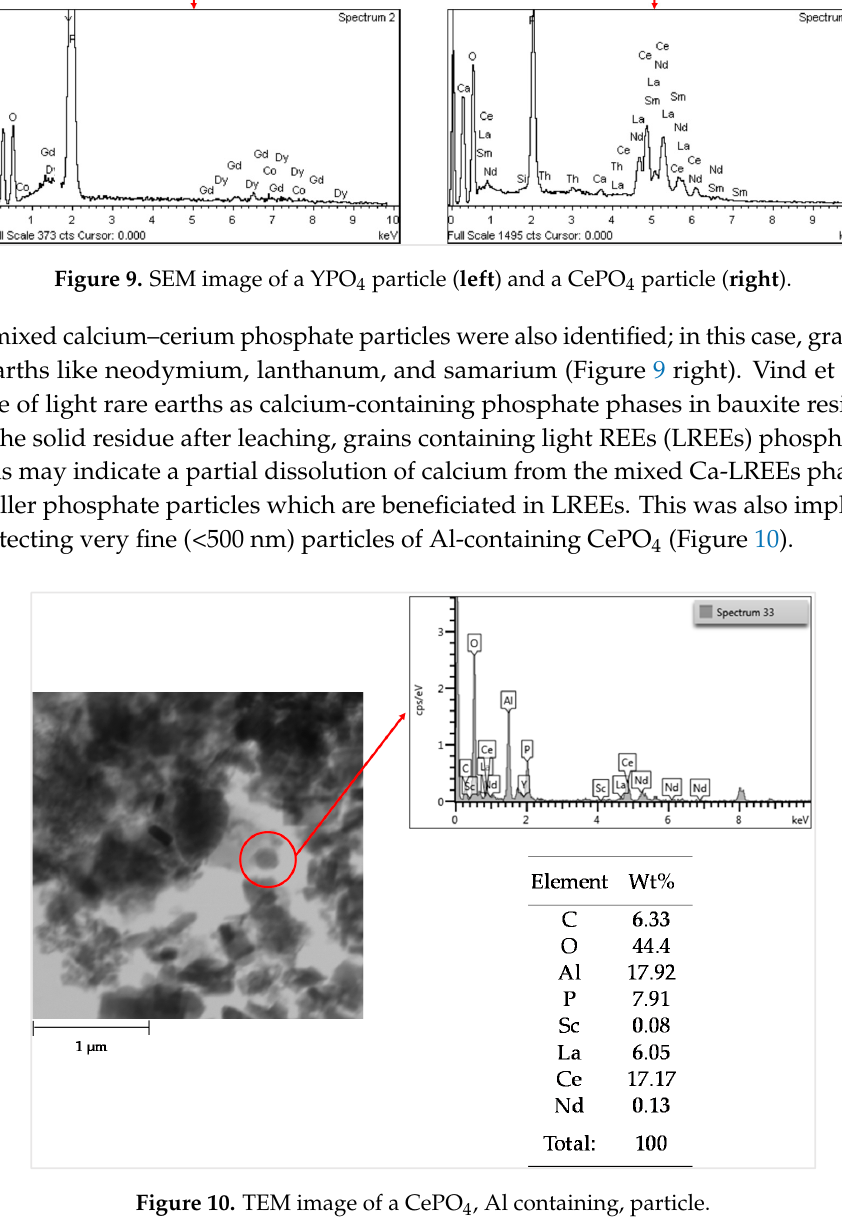
4 , Al containing,